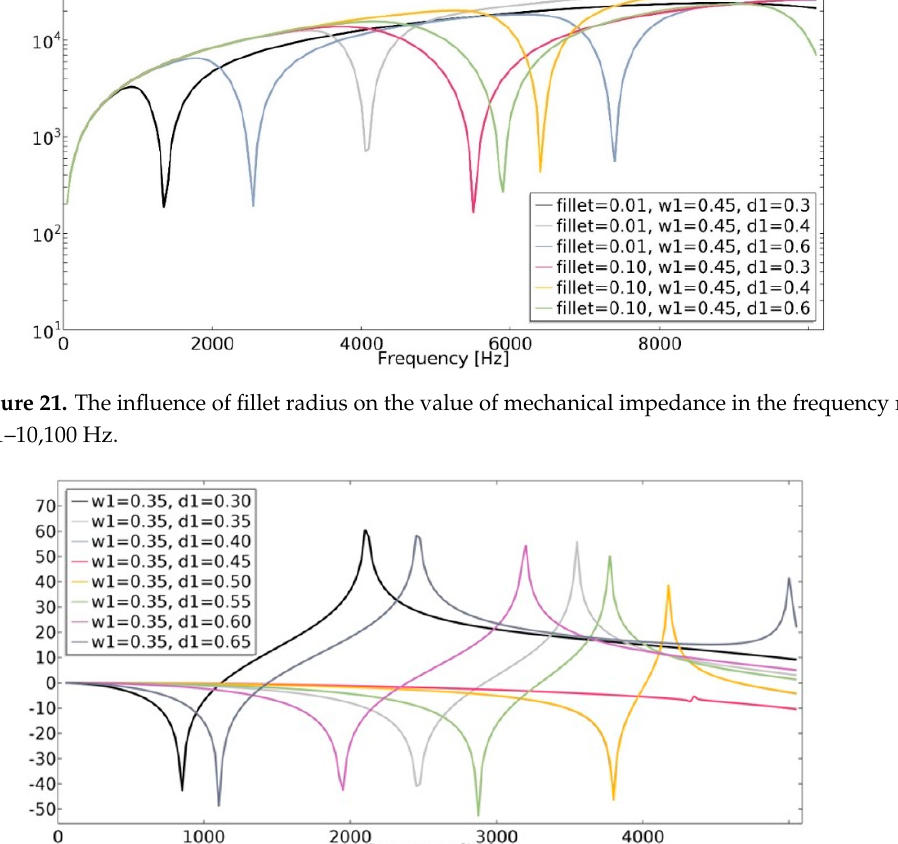
Figure 22. The influence of geometric features on the value of VTL for w 1 = 0.35.